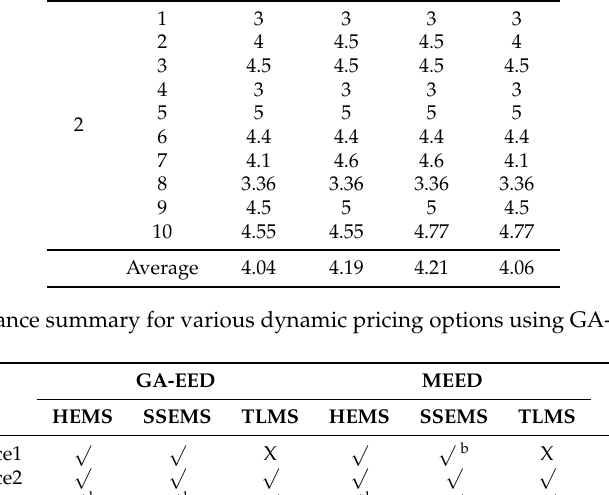
Table 8. Comfort C i for each pricing option for Str i , j